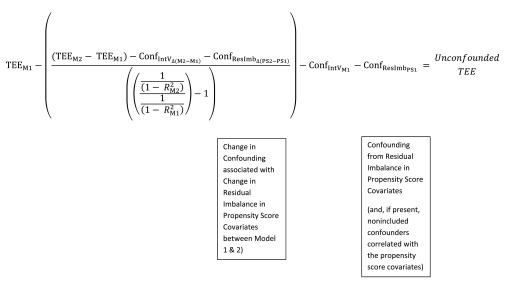
ACCE Method Summary Equation including additional elements relating to residual confounding attributable to the residual imbalance in the covariates included in both propensity scores (
Appendix 2.1 and
Appendix 3.2a).Abbreviations for
Appendix Figure 1c.Same as for
Appendix Figure 1a and
Appendix Figure 1b (above), plus:Conf
ResImb
Δ(PS2-PS1) = Confounding associated with the change (if any) in the residual imbalance between treatment groups observed in propensity score covariates in Model 1 versus Model 2. This can be estimated through inserting multivariate regression coefficients for each covariate into the Bross equation, incorporating information about the change in balance of the propensity score covariates in Model 1 and Model 2. I use the more general term “associated with”, rather than “attributable to”, to reflect the fact that changes in the balance of these included covariates would be expected to also result in change in the balance of the “included fraction” of nonincluded confounders that are correlated with these covariates. How well the Bross equation adjusts for these changes is uncertain.Conf
ResImb
PS1 = Confounding associated with the residual imbalance in propensity score covariates in Model 1, and, if present, the correlated fraction of nonincluded confounders correlated with the included propensity score covariates. The effect of the residual imbalance in propensity score covariates in Model 1 upon residual confounding may be able to be estimated through the use of the Bross equation. The ability for this estimate to include the impact upon residual confounding of any nonincluded correlates of these propensity score covariates, however, it is less certain.